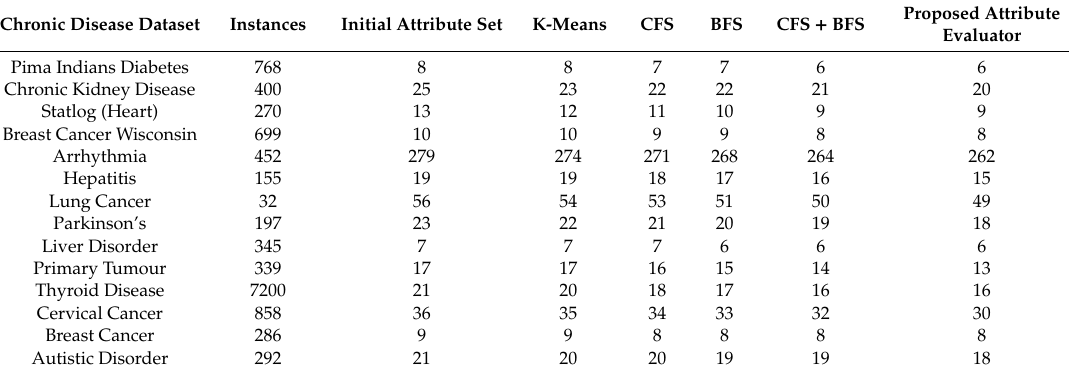
Table 13. The Impact of Proposed Attribute Evaluator Method on disease datasets. Chronic Disease Dataset